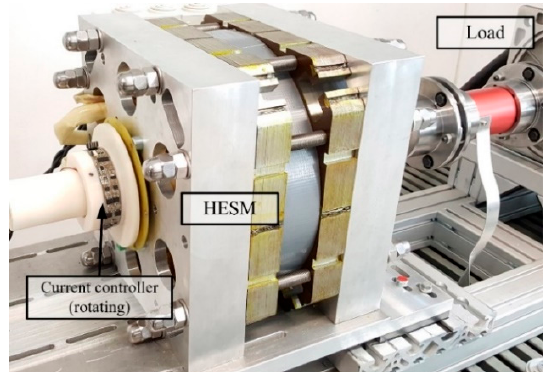
Figure 11. Test stand. Energies 2019 , 12 , x FOR PEER REVIEW